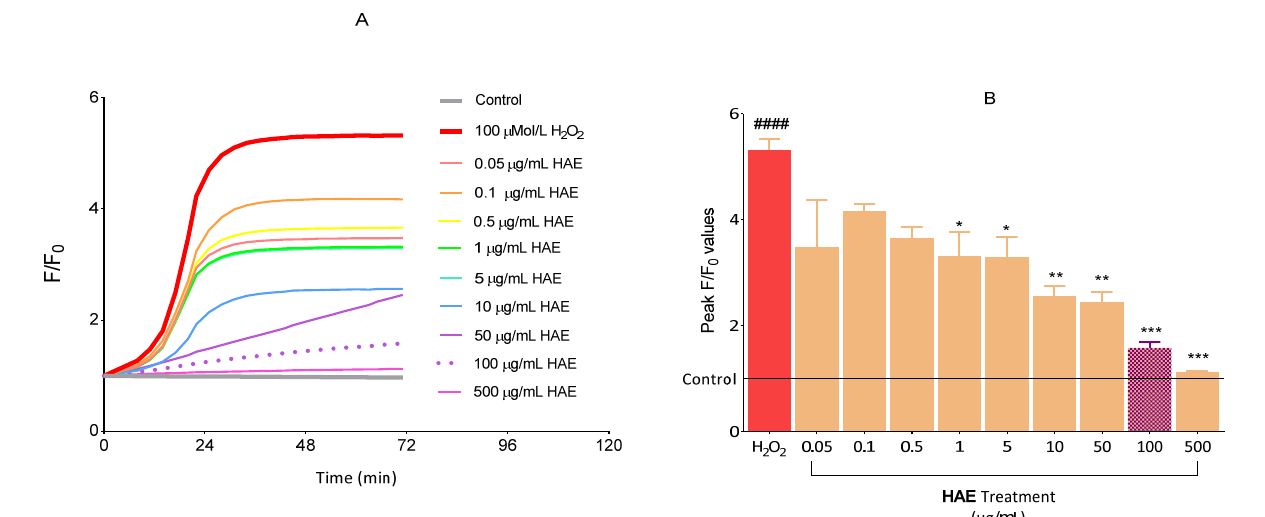
Figure 5. Fluorescent SYTOX green labelling. The effect of HAE on necrotic processes after 24 ( A ) and 48 ( B ) hours. The results are expressed relative to the control (Control = 1; 0 µg/mL HAE). Data are expressed as the mean ± SEM of four individual experiments. The thin grey solid line indicates the control level. Differences were considered statistically significant, when p < 0.05. We did not observe any statistically significant differences.